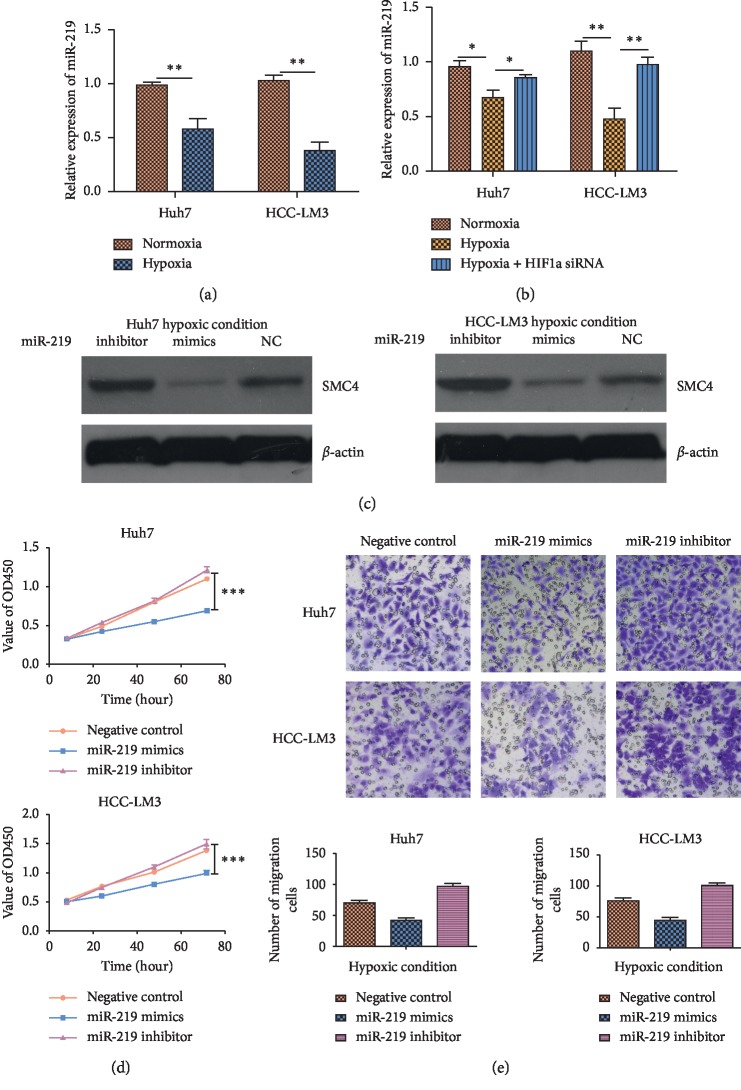
Hypoxia increases the expression of SMC4 through inhibiting the expression of miR-219. (a) mRNA level of SMC4 was detected under hypoxic or normoxic condition in HCC cells. n = 3, ∗∗p < 0.005. (b) The expression of miR-219 was detected under hypoxia or normoxia or hypoxia + HIF-1a siRNA in HCC cells. n = 3, ∗p < 0.05, ∗∗p < 0.005.(c) Expression of SMC4 was detected under treatment of miR-219 mimics, inhibitor, or negative control, and β-actin was used for internal control. (d) CCK-8 was used to detect cell viability of HCC cells with miR-219 mimics, inhibitor, or negative control under hypoxic condition. The value of 72 h was statistically analyzed. n = 7, ∗∗∗p < 0.0005. (e) Transwell assay was used to detect cell migration ability of HCC cells with miR-219 mimics, inhibitor, or negative control under hypoxic condition. n = 3, ∗p < 0.05.